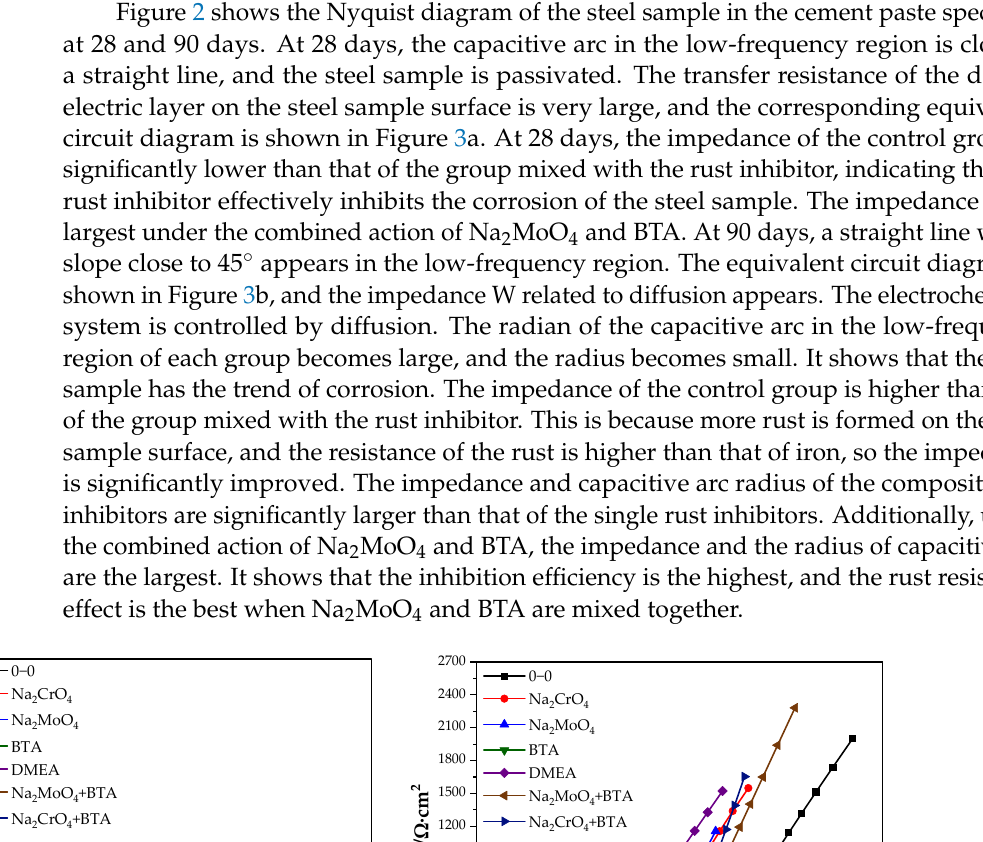
( b ) Figure 3. EIS equivalent circuit diagram. ( a ) Circuit diagram 1. ( b ) Circuit diagram 2. 3.2. XPS Analysis of the Passive Film on the Steel Sample 3.2.1. XPS Scanning Full Spectrum Analysis of the Passive Film Figure 4 shows the full scan XPS spectrum of the passive film on the steel sample surface. It can be seen from Figure 4 that the passive film mainly contains Fe, O, Ca, C, Cl, and Na elements. The elements of Ca, Cl, and Na come from Ca(OH) 2 , NaCl, NaOH, and NaHCO 3 added during the solution preparation. XPS detects the C element, and the diffraction peak of the C is powerful. On the one hand, it is because the steel sample contains C. On the other hand, since the C element [28] does not exist in the solution, it may come from pollutants. The diffraction peaks of O and Fe are very strong, indicating that the passive film is mainly composed of iron oxide [29]. In addition, the components in the rust inhibitor also participated in the formation of the passive film. The passive film of the group mixed with Na 2 CrO 4 contains compounds related to the Cr element. Additionally, the groups mixed with Na 2 CrO 4 contain compounds related to the Mo element. In the groups containing BTA, the N peak is obviously raised after adding BTA, illustrating that the passive film contains some compounds related to the N element. The N element could only come from BTA. Additionally, the diffraction peaks of Cr, Mo, and N are powerful. By observing the binding energy of Fe 2p in Figure 4, it can be observed that the binding energy of Fe 2p changed with different rust inhibitors. This phenomenon shows that the iron oxide in the passive film has a difference in composition under the action of different rust inhibitors.